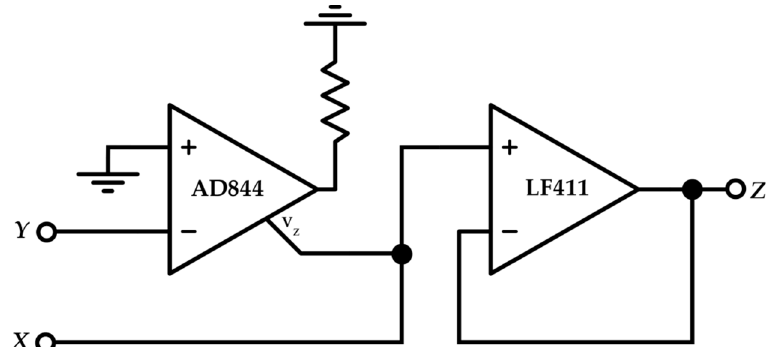
Figure 8. Discrete VCII implementation.